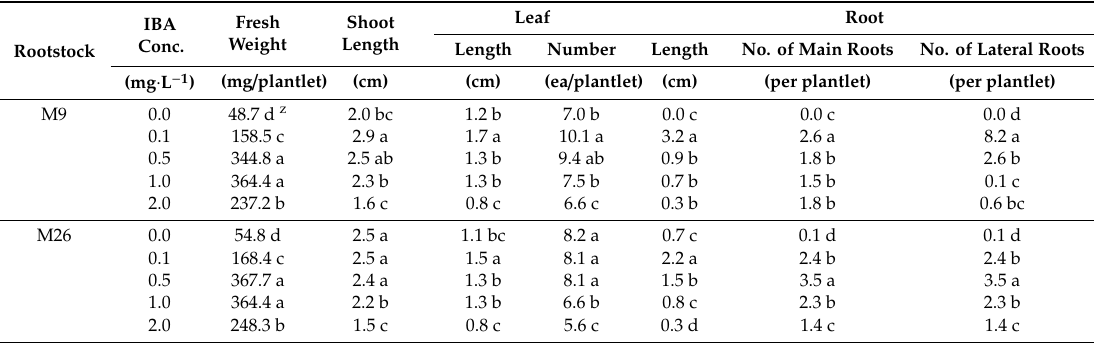
Table 2. E ff ects of various concentrations of indole-3-butyric acid (IBA) on growth and rooting of apple rootstocks M9 and M26 after 4 weeks of in vitro